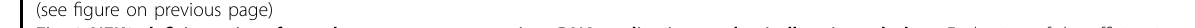
Fig. 3 NEK3 de fi ciency interferes chromosome segregation, DNA replication, and spindle microtubule. a Evaluation of the ef fi ciencies of three siRNAs targeting NEK3 in human RPE cells by western blots. Right panel: Quanti fi cation data of NEK3 expression level when normalized against GAPDH. * p value<0.05 (Mann – Whitney U test). AU arbitrary units. Representative image from three independent experiments was displayed. b Volcano plots showing the differentially expressed genes (DEGs) ( p value <0.05; fold-change>2) for each group. Up- and downregulated genes are highlighted red and blue, respectively. c Numbers of DEGs were displayed. Up- and downregulated genes are highlighted red and green, respectively. d Overlap of DEGs between different groups as indicated. e GO enrichment analysis of 342 D E Gs revealed that chromatid segregation, DNA replication, and spindle microtubule were the top 3 enriched